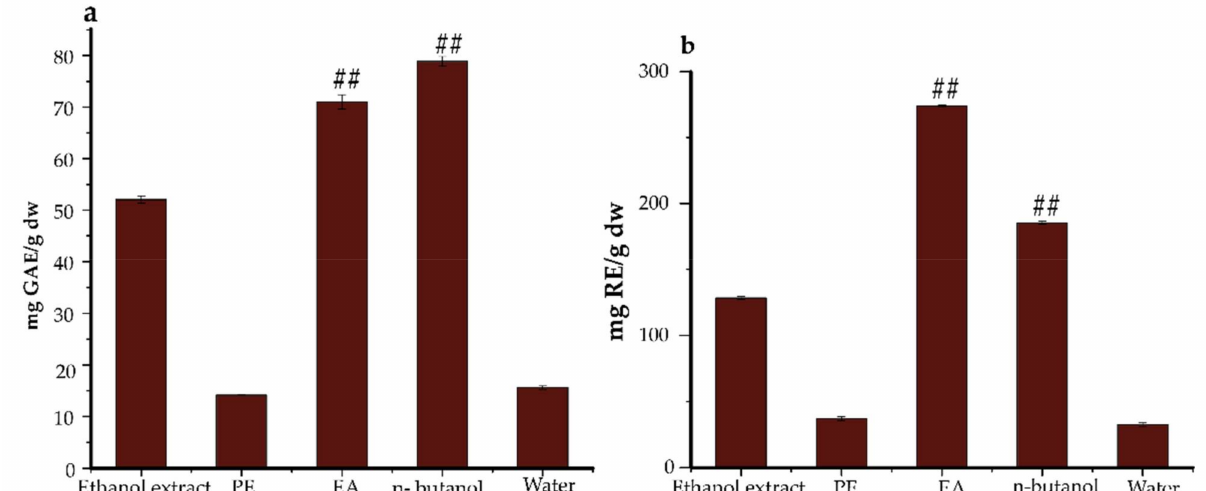
Figure 1. ( a ) (TPC) The total phenolics content and ( b ) (TFC) total flavonoids content of Ficus glumosa . The results are expressed in GAE (gallic acid equivalents) and RE (rutin equivalents) based on dry weight samples. ## p < 0.01 as compared to ethanol extracts. PE, Petroleum ether; EA, ethyl